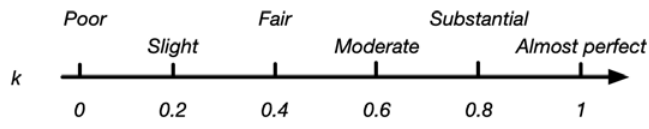
Figure 7. The interpretation of the kappa coefficient.